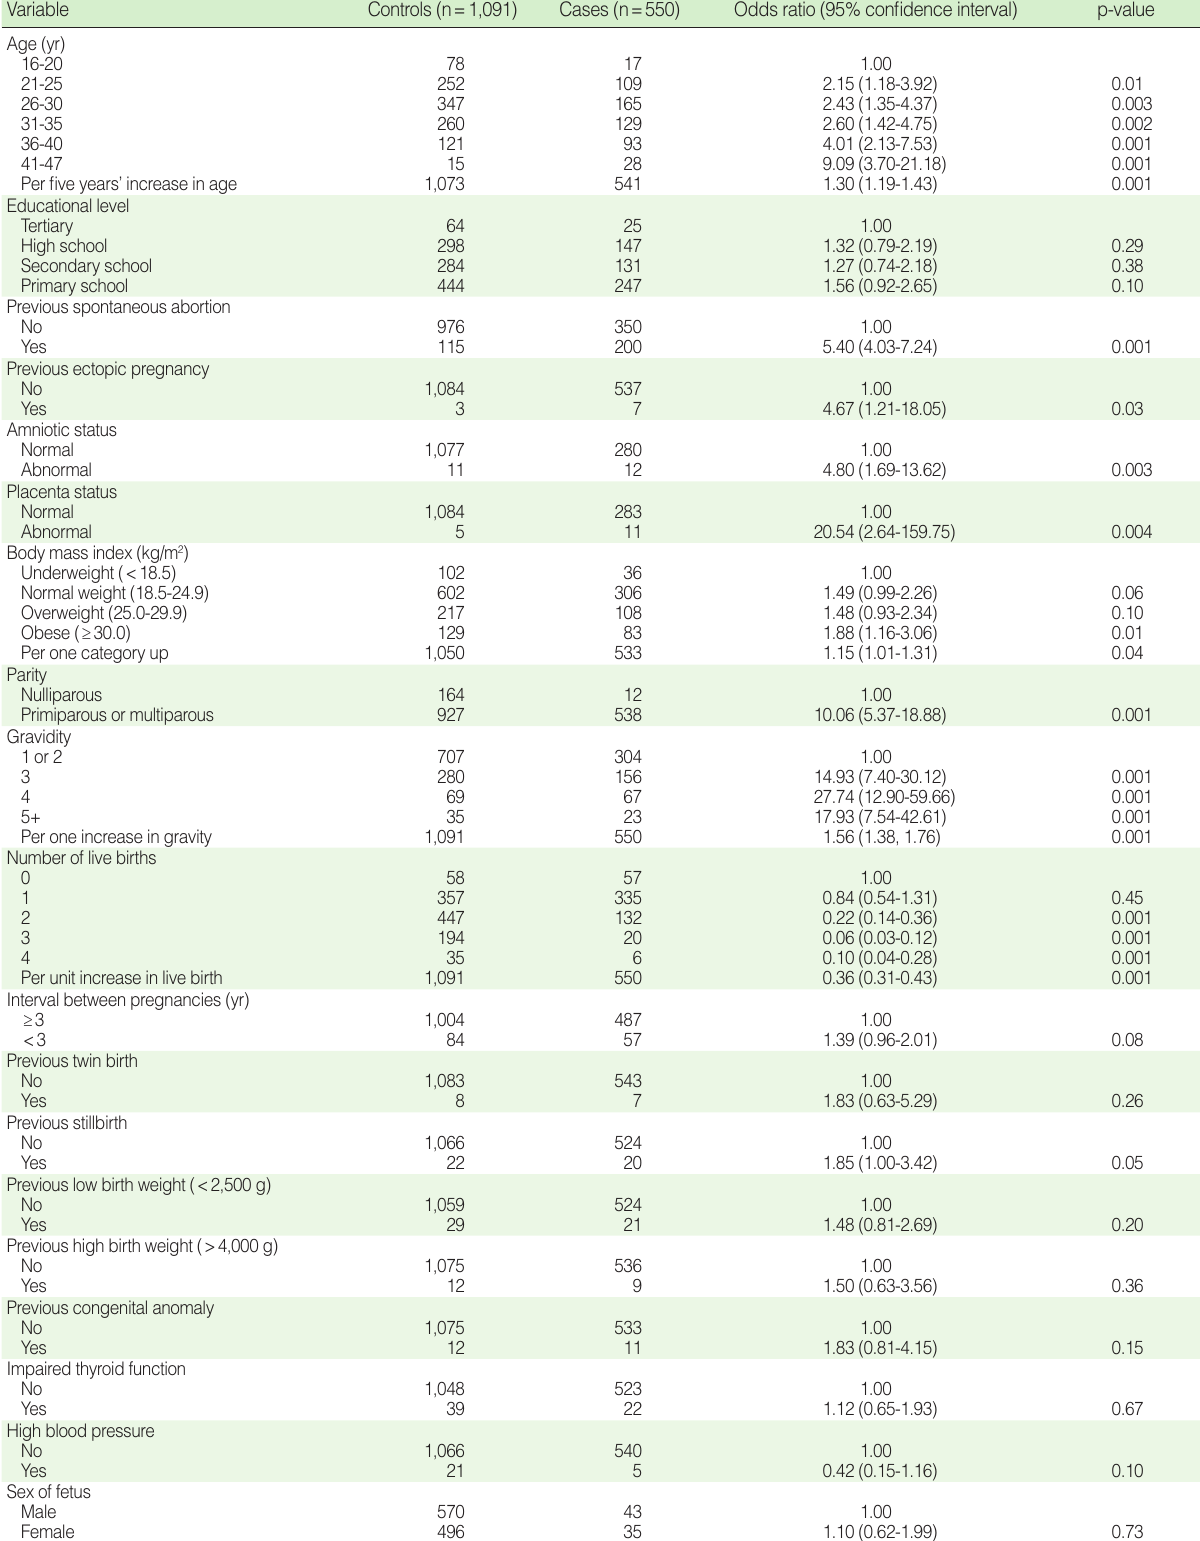
Table 2. Results from bivariate conditional logistic regression analyses of several binary and continuous predictors of miscarriag Variable Controls (n=1,091) Cases (n=550) Odds ratio (95% confidence interval)